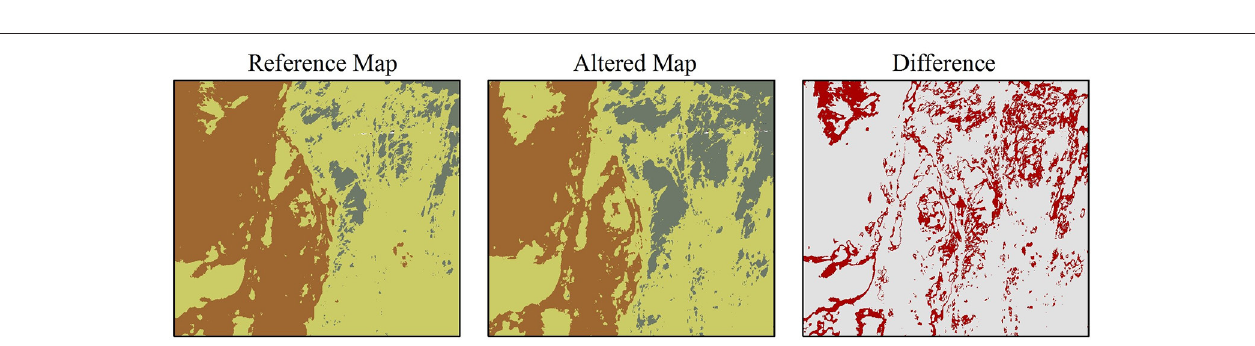
FIGURE 4 | Example of how using the same data at different scales can produce different outcomes. The reference map is the same as in Figure 2 . The two altered maps were computed using the same methods and the same data but generated at 25m (top) and 100m (down) spatial resolution.